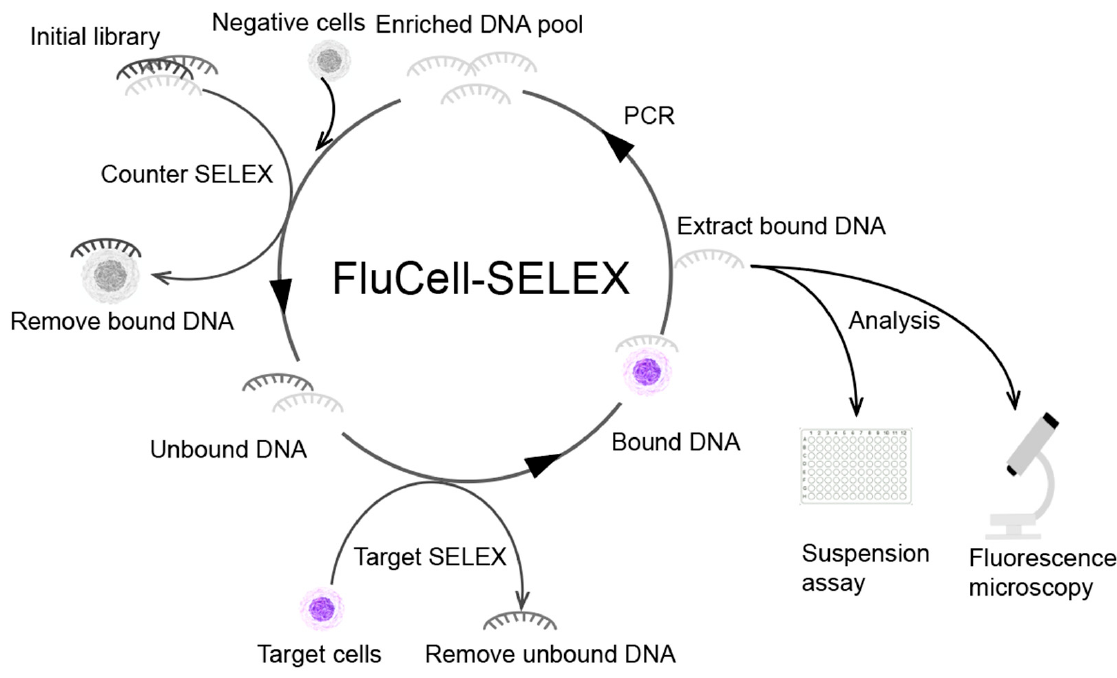
Figure 1. The initial library was first incubated in a counter SELEX with a mixture of bacteria including A. muciniphila , A. steroricanis , B. producta , R. microfusus , and R. intestinalis . Aptamers attached to negative or non ‐ target cells were removed by centrifugation. Through this process, the selection pressure was increased to improve the screening efficiency. Subsequently, the unbound aptamers were further incubated with B. producta by Target ‐ SELEX to obtain aptamer sub ‐ populations. Ap ‐ tamers not attached to B. producta were removed by simple washing, and then the aptamer sub ‐ populations were amplified by PCR after elution to obtain a new focused DNA pool. This screening